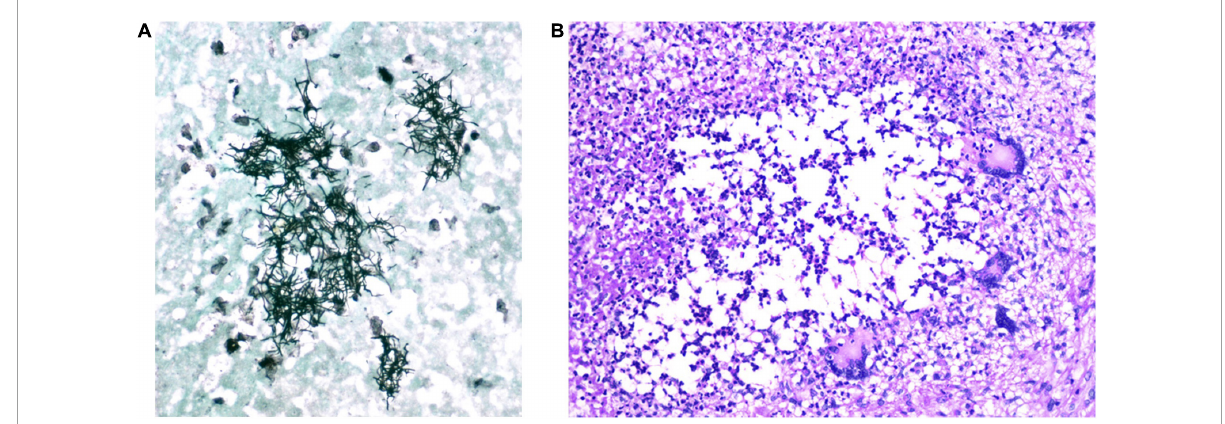
FIGURE2 Patohistology finding of the material obtained on surgery (A) Grocott methamine silver staining shows branching microfilamentous bacilli of Nocardia spp. (B) Hematoxylin-eosin staining (magnification 200x): necrotizing granulomas of different sizes with the presence of multi-nuclear Langhans giant cells.